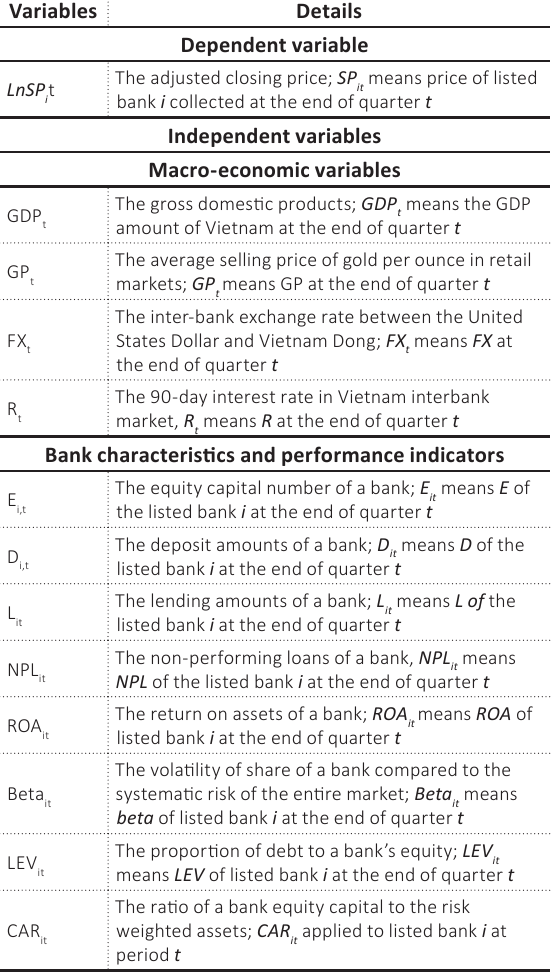
Table 1. Variables used in the